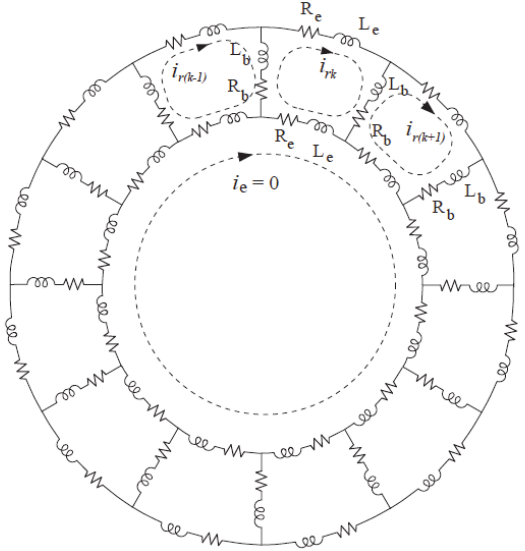
Figure 1. Squirrel cage rotor representation, figure taken from [29] (p. 60).